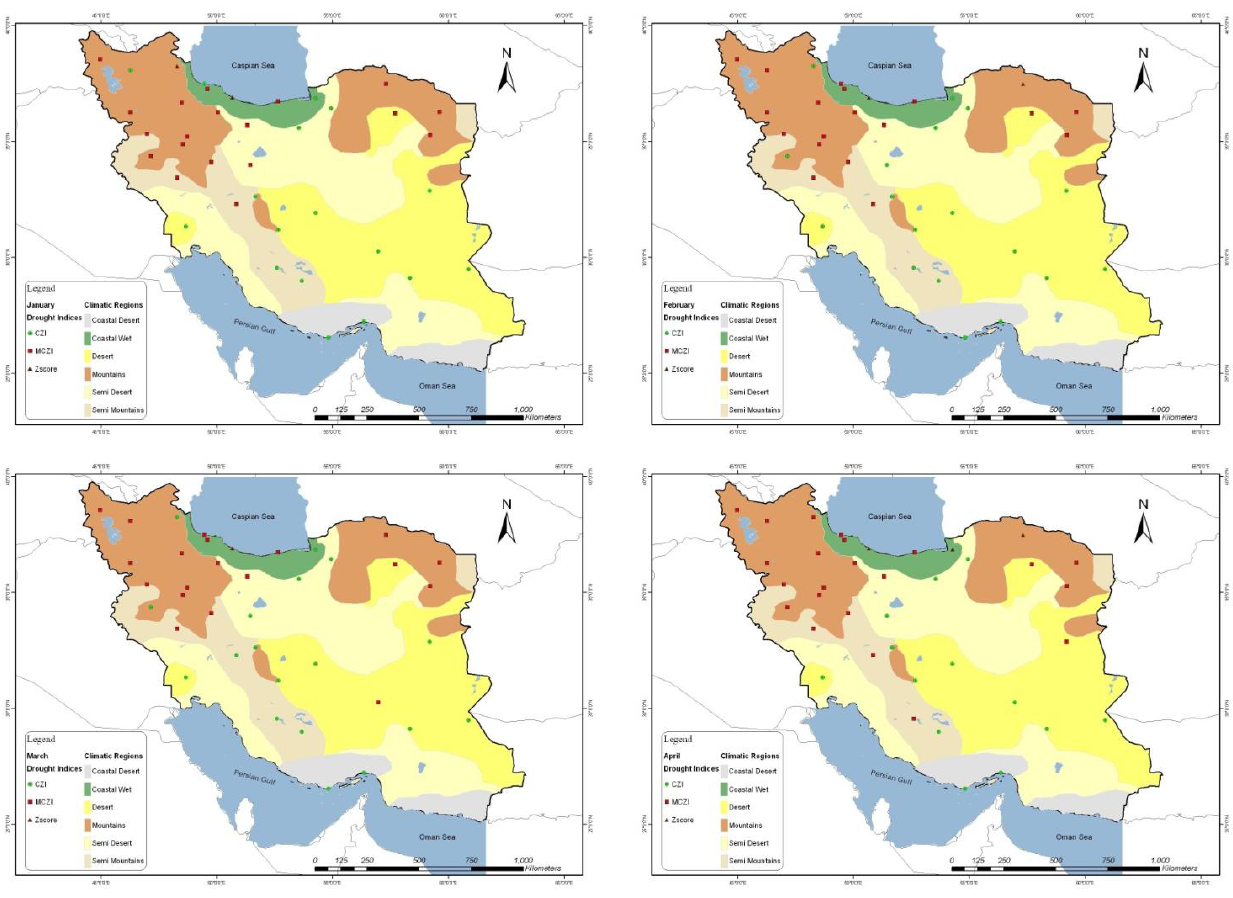
Figure 3. Spatial distribution of monthly drought indices with the best correlation to standardized precipitation index (SPI) for January, February, March and April.